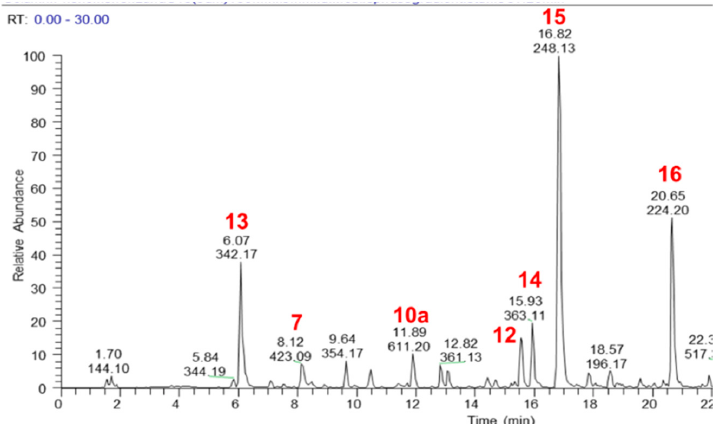
Figure 2. LC–MS base peak chromatogram (positive ionisation mode) of a MeOH extract of CareVid. For compound identities, refer to Section 2.1 or Table S1 in Supplementary Files.